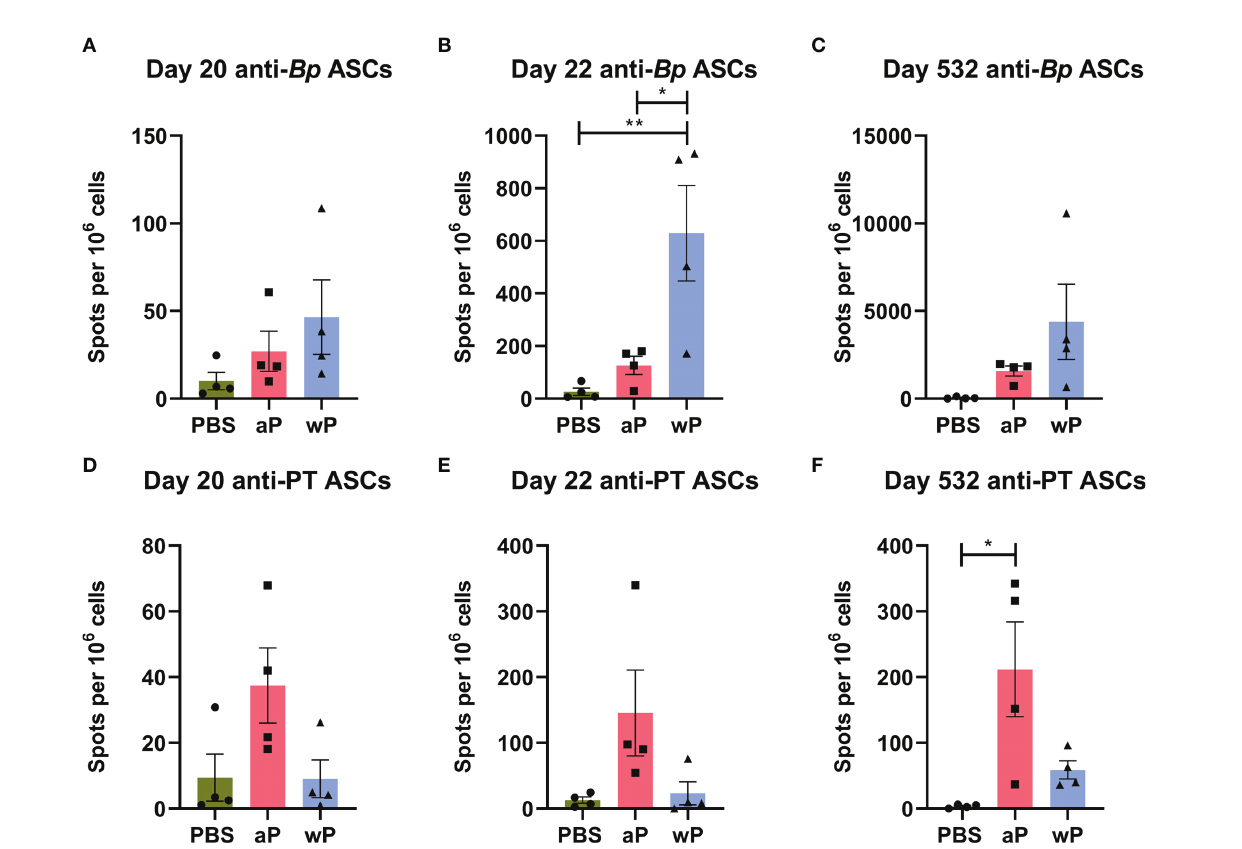
FIGURE 5 | Anti- B. pertussis and anti-pertussis toxoid antibody secreting cells (ASCs) in immunized CD1 mice persist as far as day 532 post-prime. ASCs were analyzed at day 20, 22, and 532 post-vaccination in non-challenged, immunized mice. Anti- B. pertussis ASCs are shown for day 20 (A) , day 22 (B) , and day 532 (C) . Anti- pertussis toxoid ASCs are shown for day 20 (D) , day 22 (E) , and day 532 (F) . To note, there is a lack of PT in the NIBSC wP formulation due to manufacturing practices. All time points are from one independent experiment (n=4) and day 365 (n=8). The p-values were calculated using ANOVA followed by a Tukey's multiple-comparison test, *p < 0.05 and **p < 0.01. Error bars are mean ± SEM values (n=4), aP (n=4), and wP